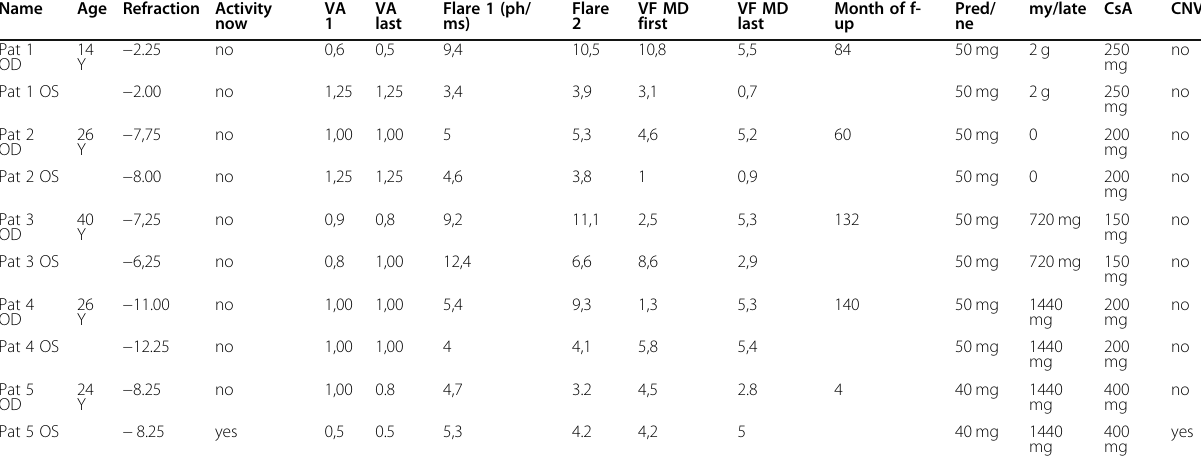
Table 3 Patients, treatment data, visual acuities, visual fields and